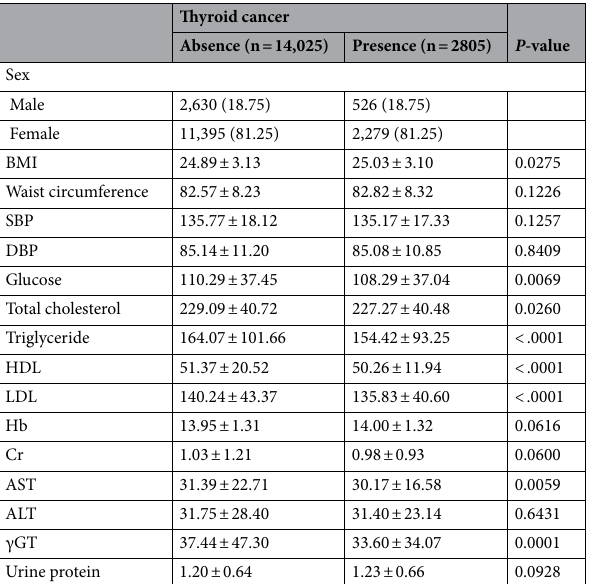
Table 1. Baseline characteristics in patients with NAFLD or dyslipidemia according to thyroid cancer in Korean national cohort after matching. BMI body mass index, SBP systolic blood pressure, DBP diastolic